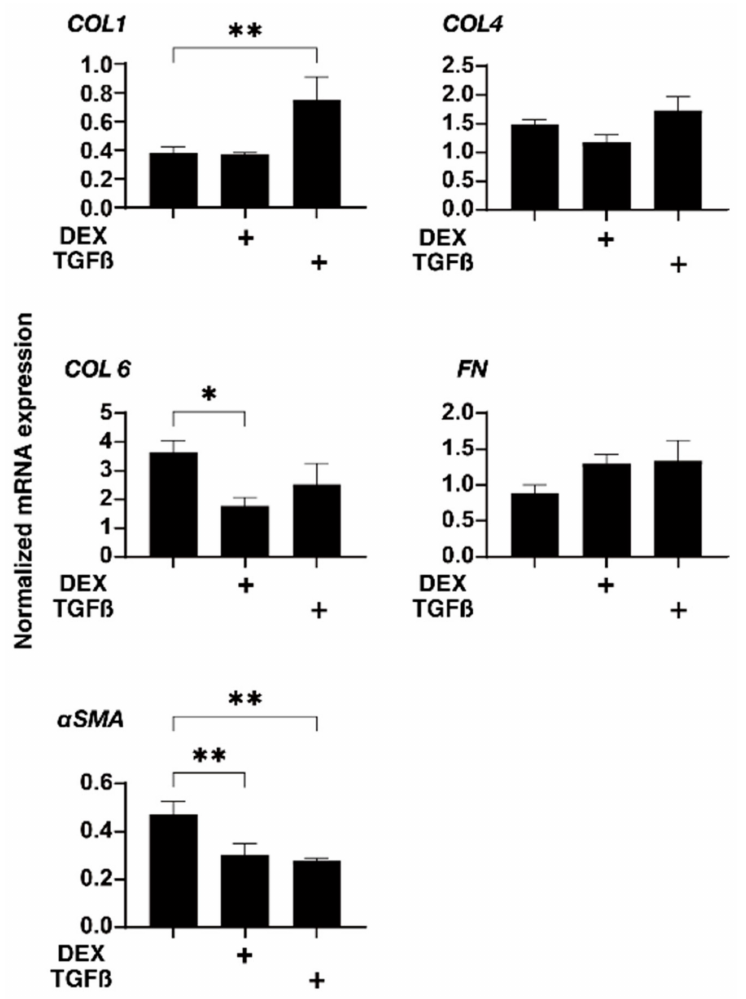
Figure 5. mRNA expression of the ECM proteins of the 3D HTM spheroids after a mechanical compression stress for 30 min. In the presence of 5 ng/mL TGF- β 2 (TGF) or 250 ng/mL DEX, the 3D HTM spheroids were mechanically compressed on day 6 for 30 min and subjected to a qPCR analysis to estimate the expression of mRNA of the ECM proteins ( COL 1 , COL 4 , COL 6 , FN ). These data were compared with those of the untreated 3D HTM spheroids compressed for 30 min (as above). All the experiments were performed in duplicate using fresh preparations ( n = 4). The data are presented as the arithmetic means ± standard error of the mean (SEM). Note: * p < 0.05, ** p < 0.01, (ANOVA followed by Tukey’s multiple comparison